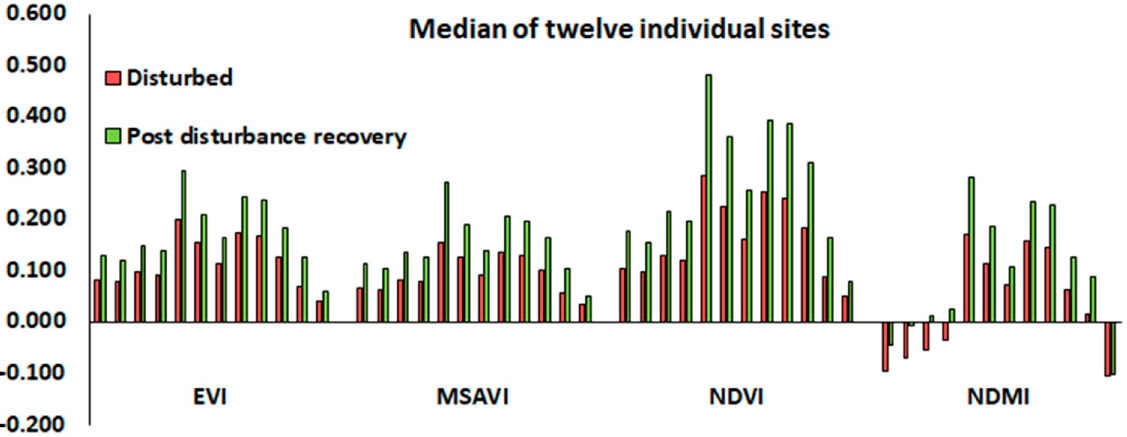
Figure 8. Median index values for disturbed and post disturbance recovery of mangroves for all twelve sites (Disturbance: 1987–2012, Recovery: 2013–2019).